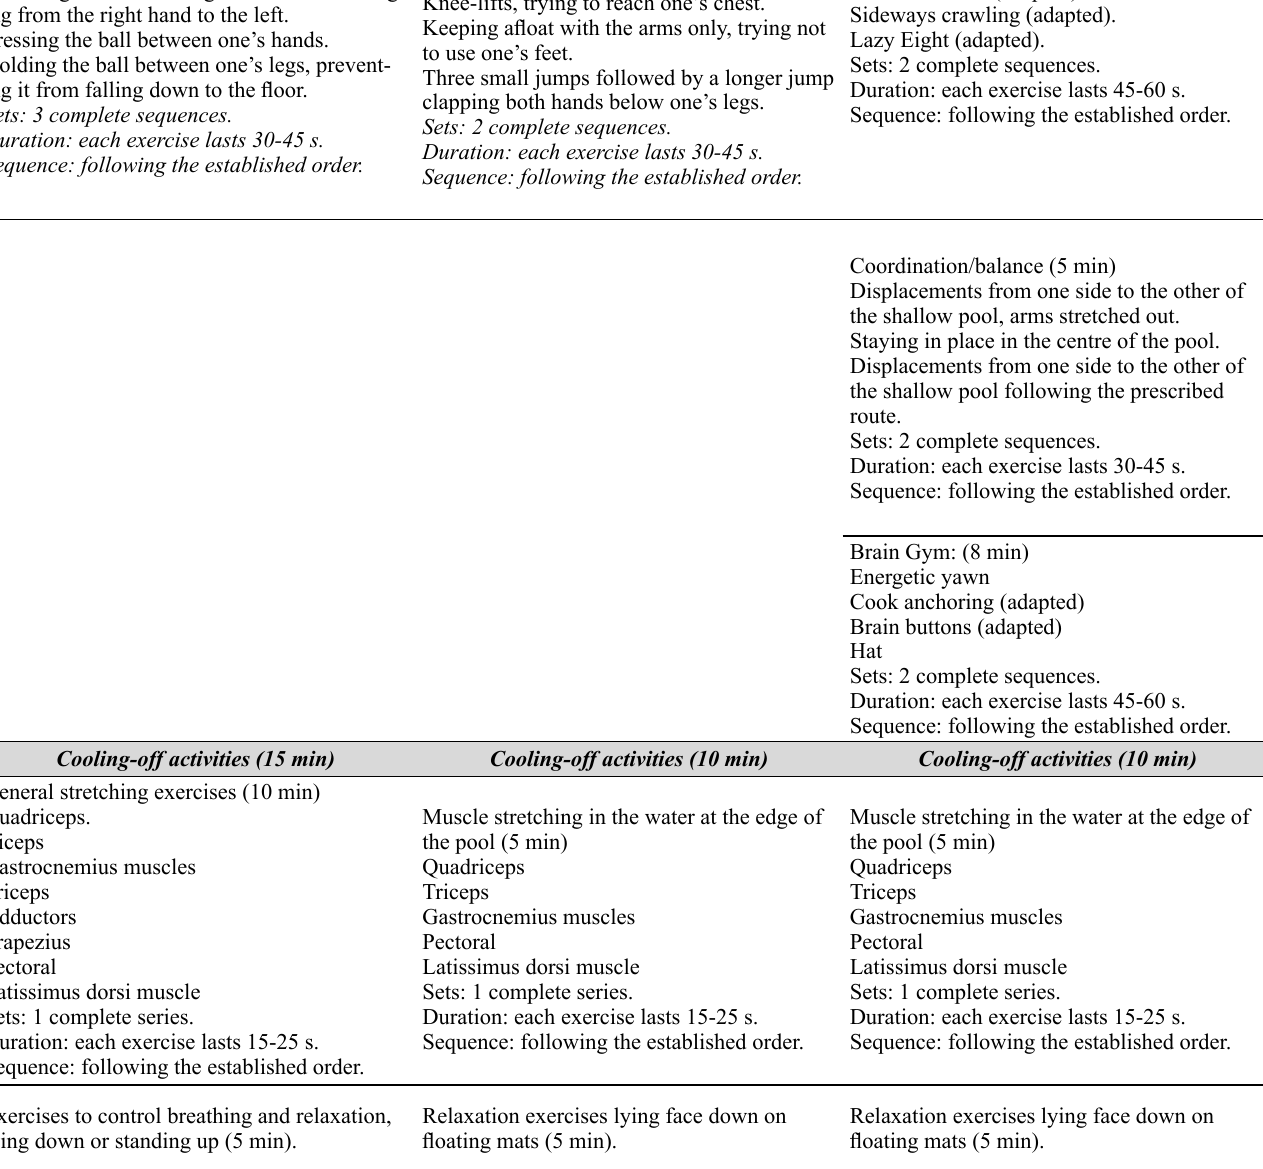
Strength-resistance (10 min) Throwing the ball and picking it up individu- ally. Bouncing the ball hard against the floor chang-